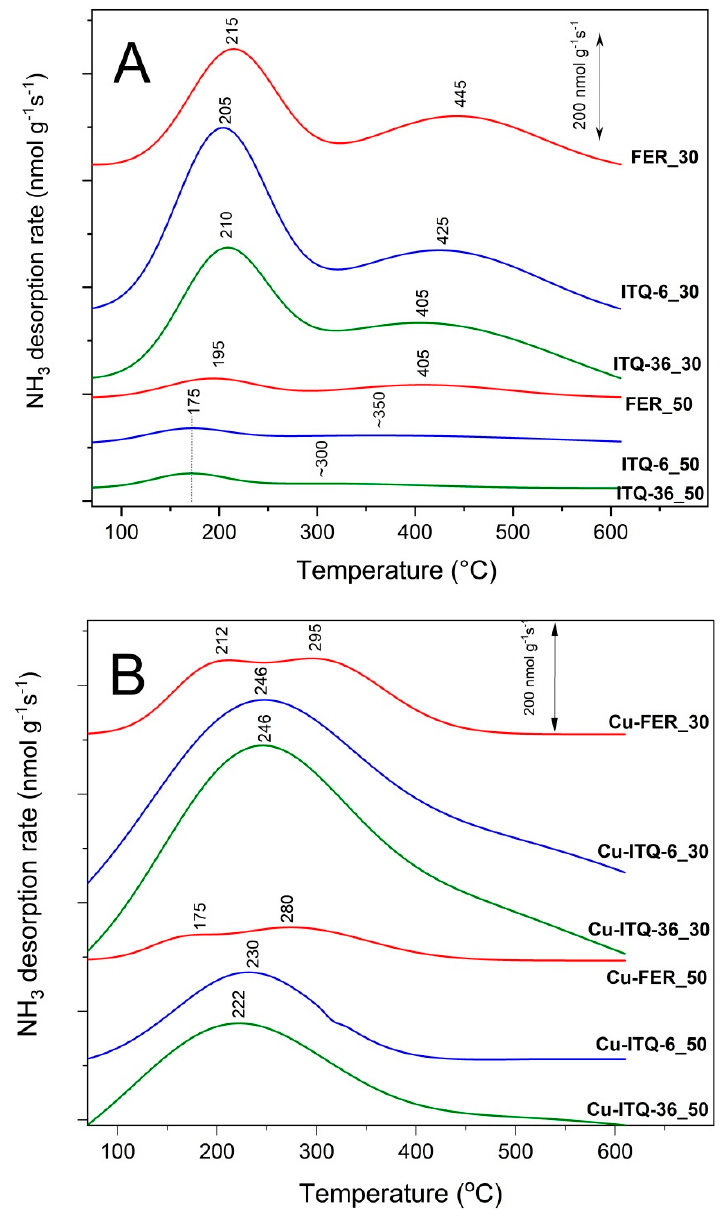
Figure 4. NH 3 -TPD profiles of FER, ITQ-6 and ITQ-36 zeolites ( A ) and their modifications with copper ( B ).